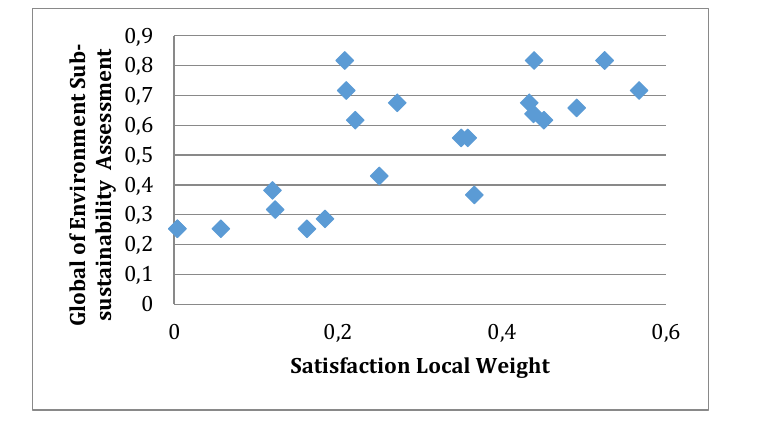
Figure 28: Global weight vs. satisfaction local weight of environment sub-sustainability assessment, micro-scale literature based assessment